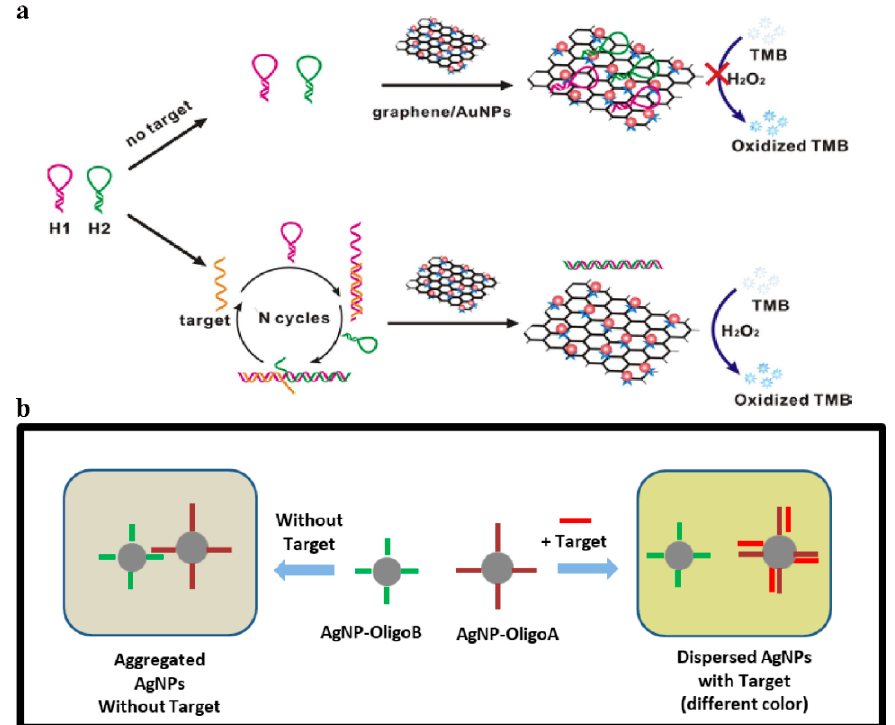
Figure 12. ( a ) Schematic of the label-free colorimetric platform for DNA by target-catalyzed hairpin assembly and the peroxidase-like catalytic of graphene/AuNPs hybrids. Reprinted with permission from Ref. [130]. Copyright 2016 Elsevier; ( b ) Schematic diagram of the sensing principle for miRNA detection by AgNPs-based assay. Reprinted with permission from Ref. [156]. Copyright 2021 MDPI.